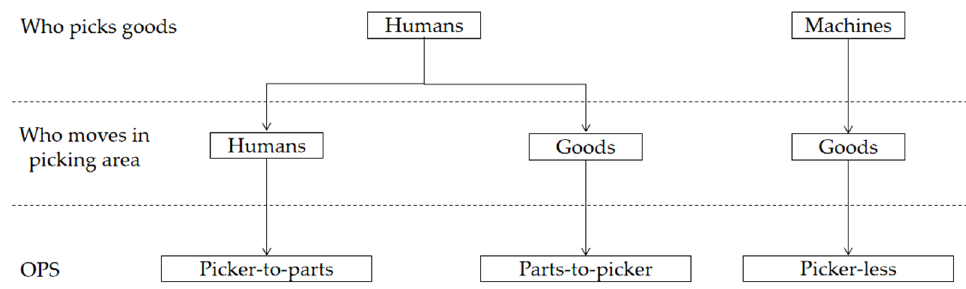
Figure 3. Order picking system classification [8,11,12].